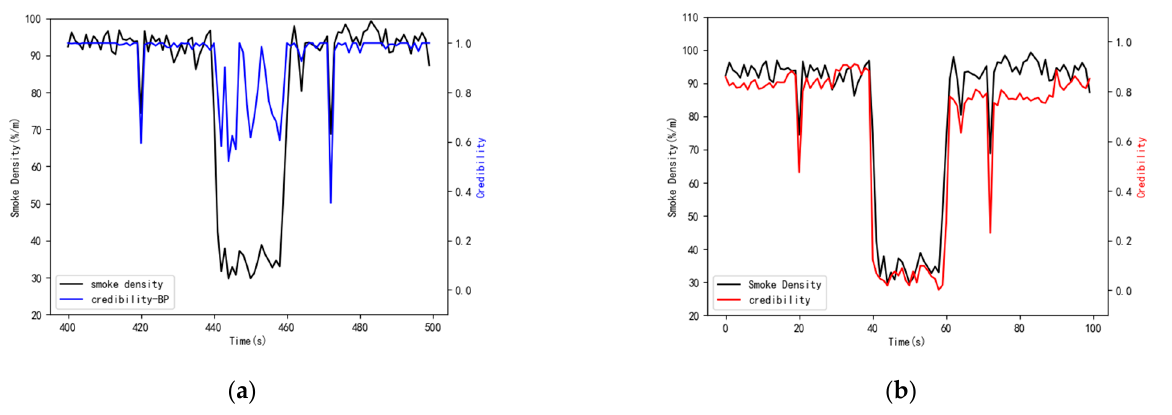
Figure 18. The evaluation result of data credibility. ( a ) Results of the BP assessment of data credibility. ( b ) Results of the comprehensive data credibility.